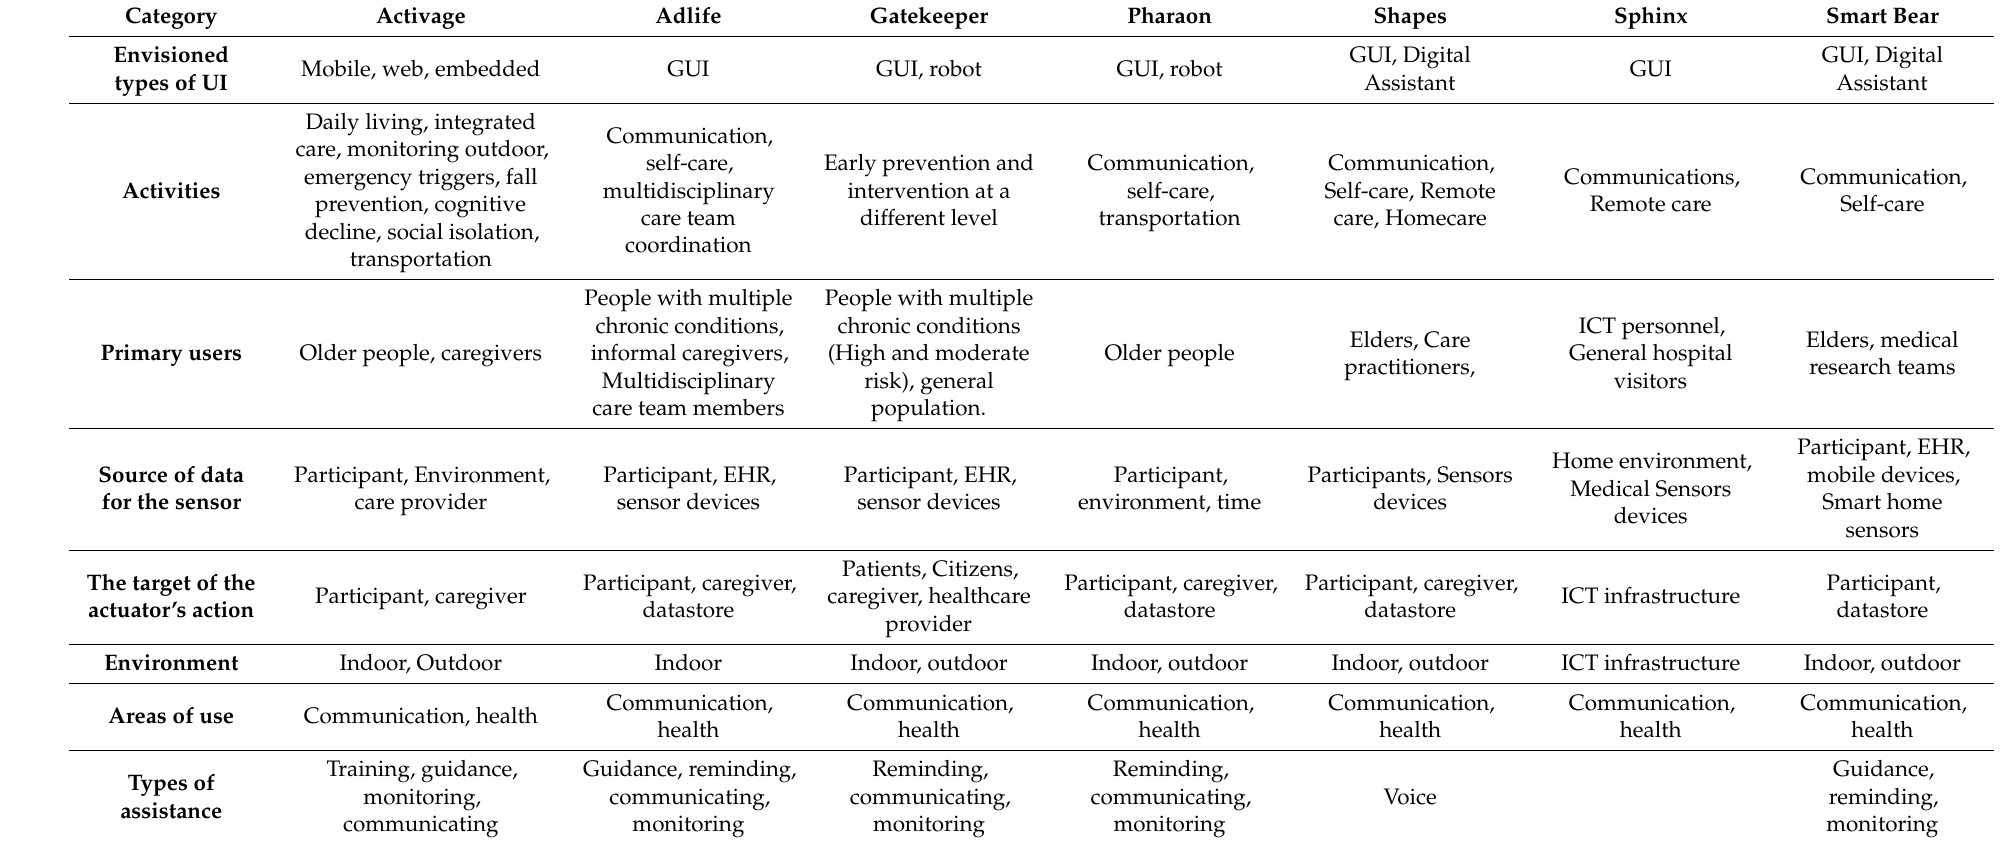
Table 1. Projects’ classification based on Pervasive Healthcare Systems (PHS)